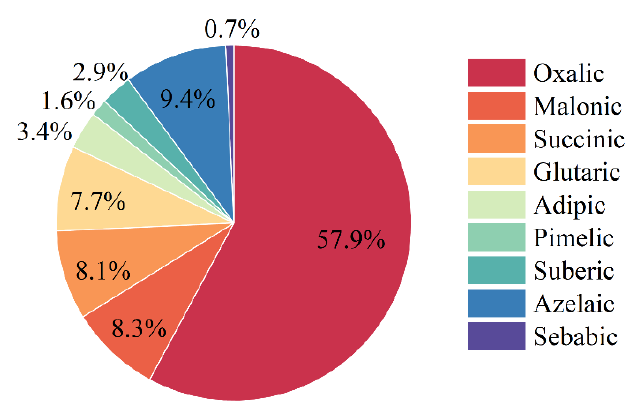
Figure 2. Annual average distribution of dicarboxylic acids at BS from 2013 to 2014.